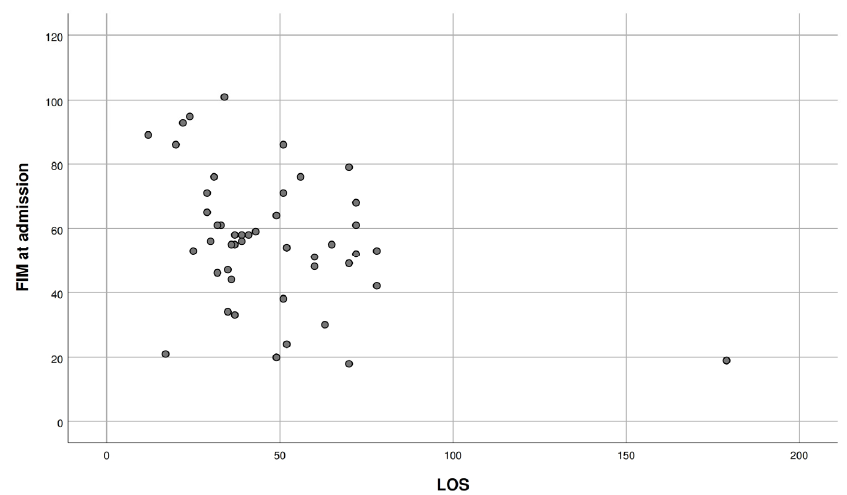
Figure 2. Inverse correlation between FIM at admission and LOS. FIM: Functional Independence Measure. LOS: Length of Stay.